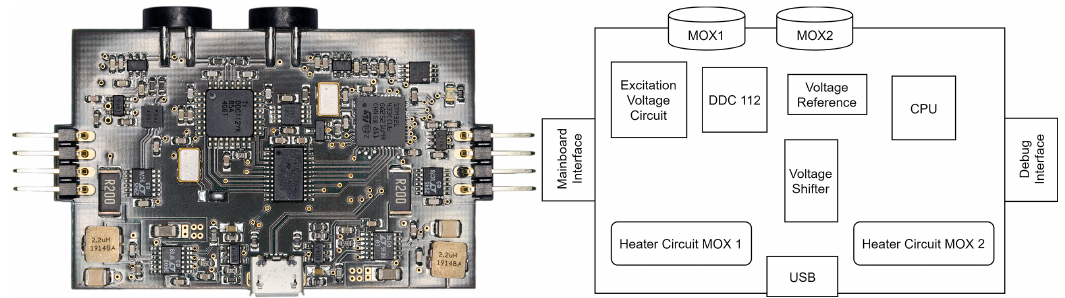
Figure 2. ( Left ) The built prototypical sensor module. ( Right ) Simplified floorplanning diagram showing the positions of the most important building